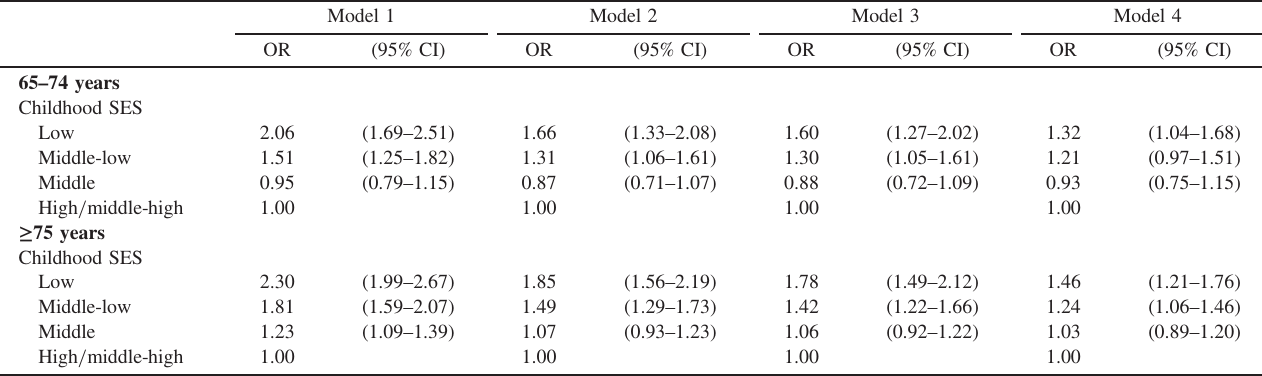
Table 3. Age-strati fi ed analysis on the associations between childhood socioeconomic status and subjective dementia symptoms